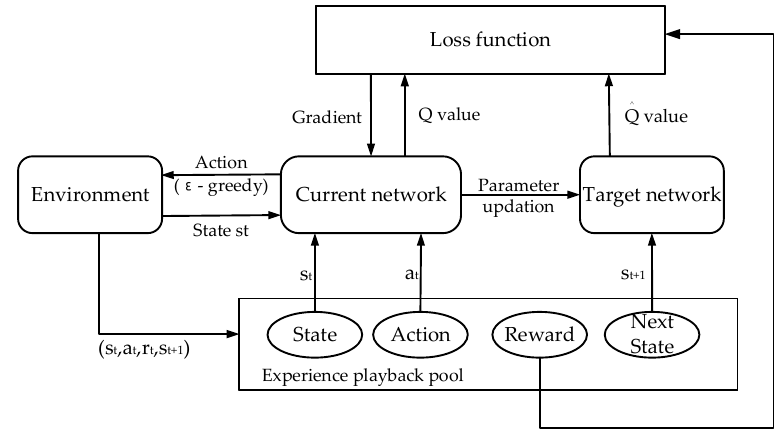
Figure 2. Training process of the DDQN-based mobile device agent.